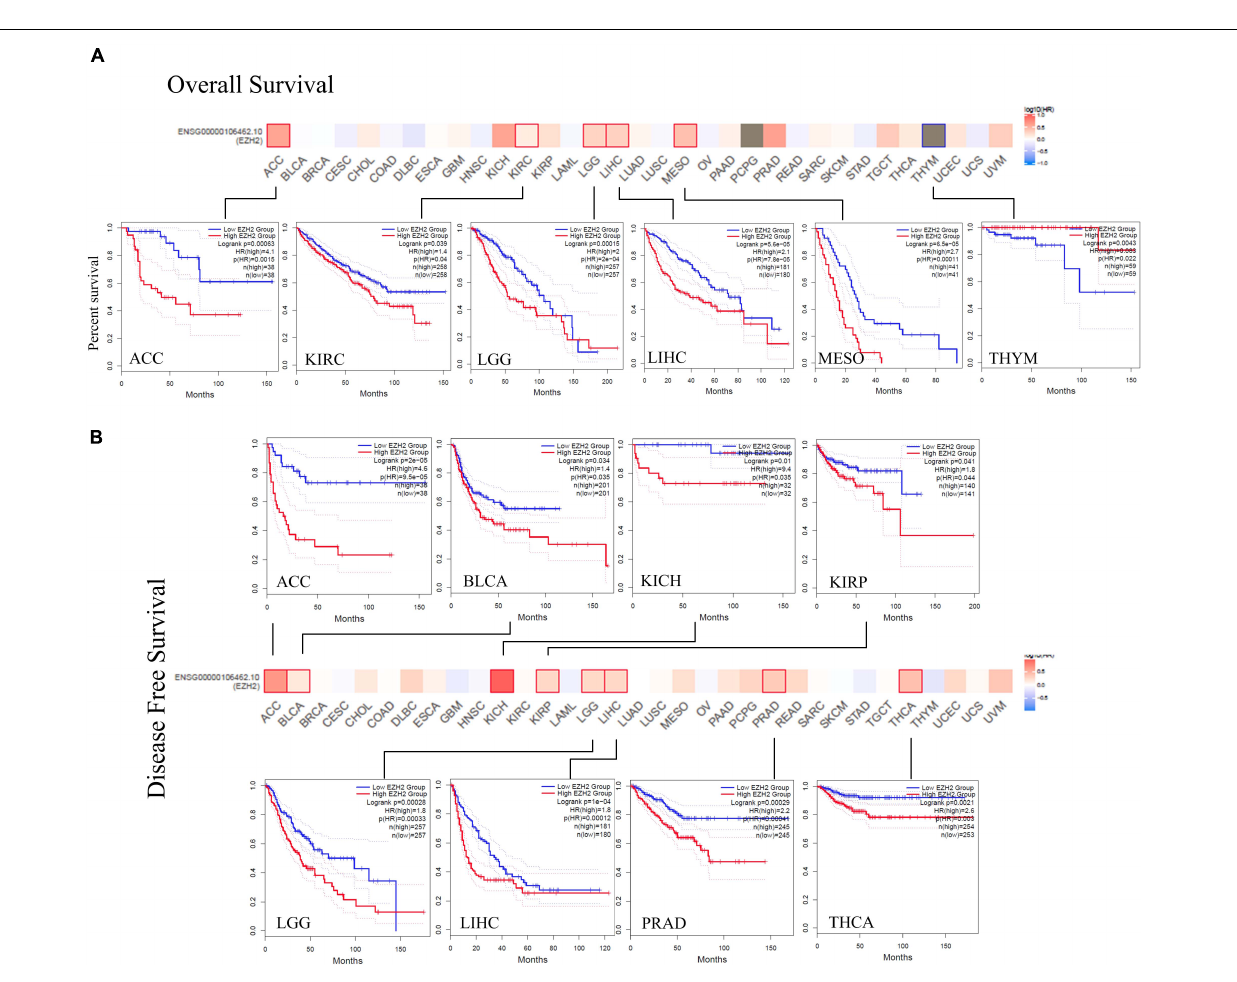
Frontiers in Genetics |